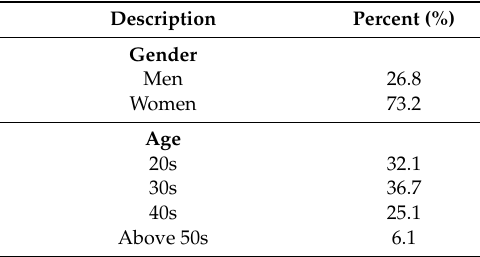
Table 1. Descriptive characteristics of the